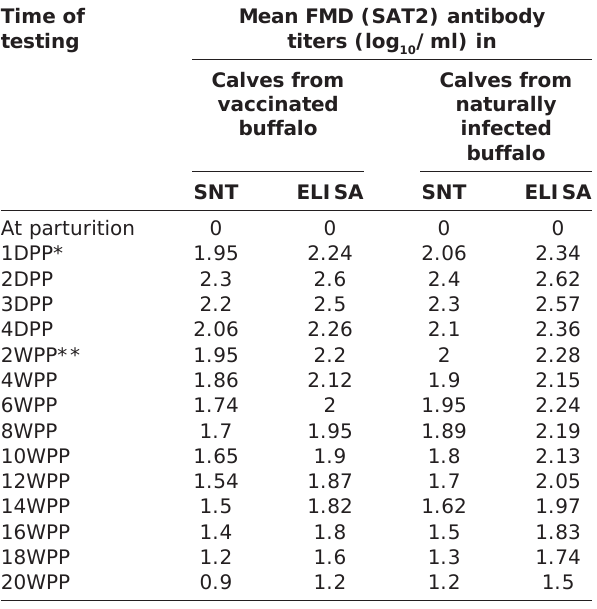
Table-3: Monitoring the mean FMD (SAT2) antibody titers in sera of buffalo calves born to vaccinated and infected buffalo cows.